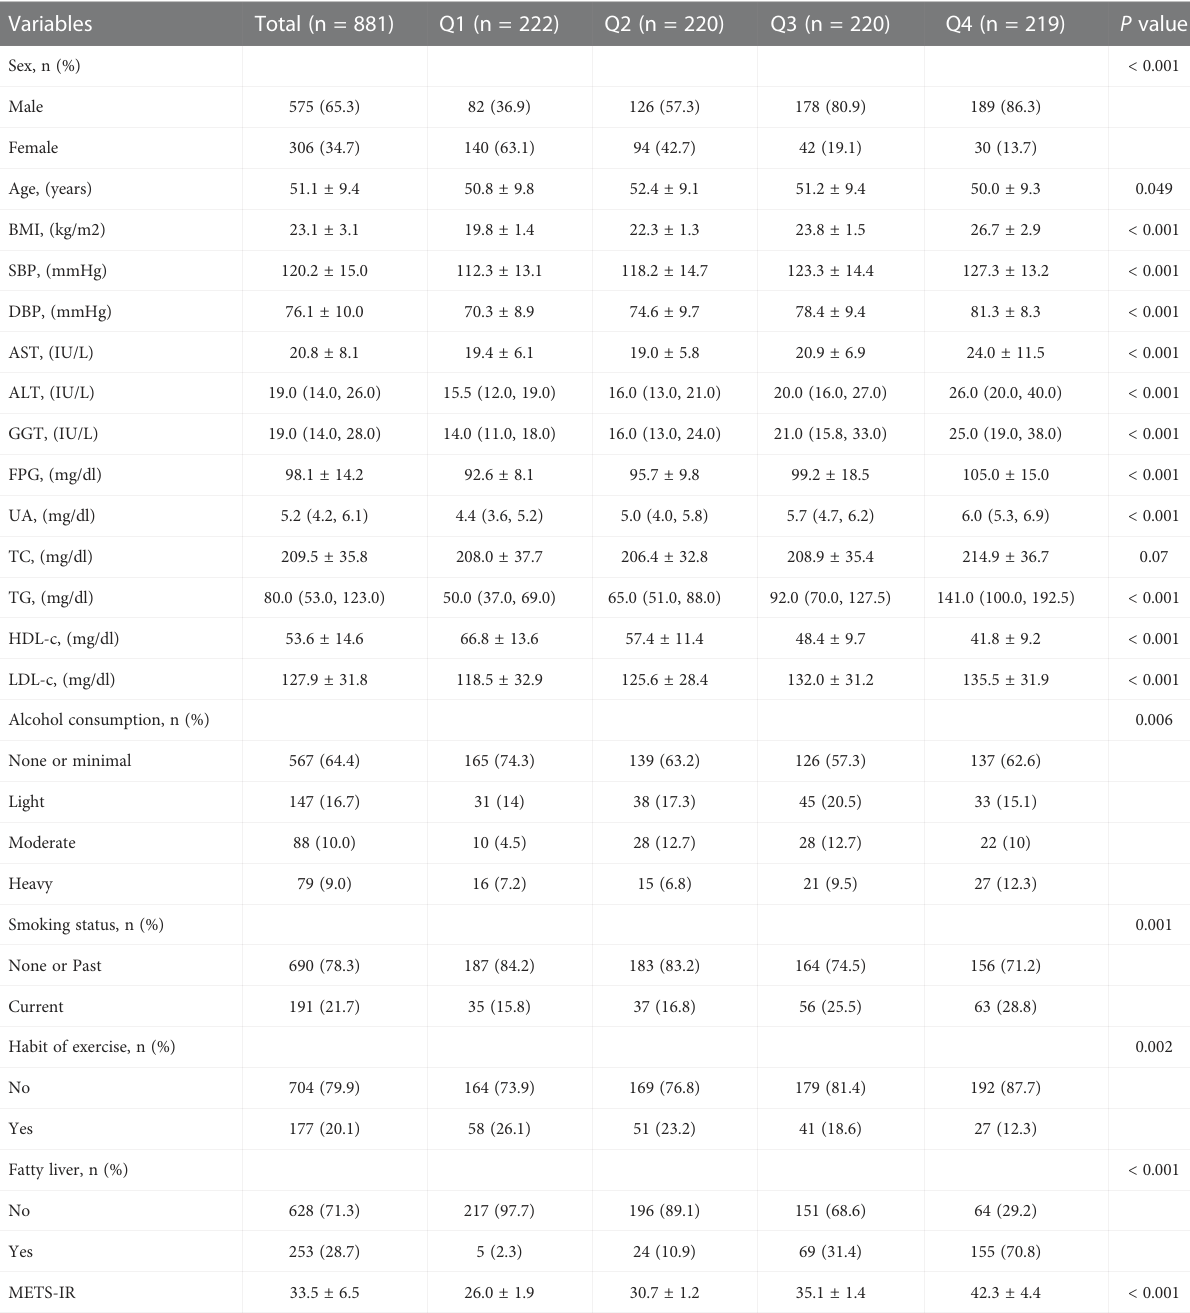
TABLE 1 Baseline characteristic of the study population according to METS-IR. Variables Total (n =